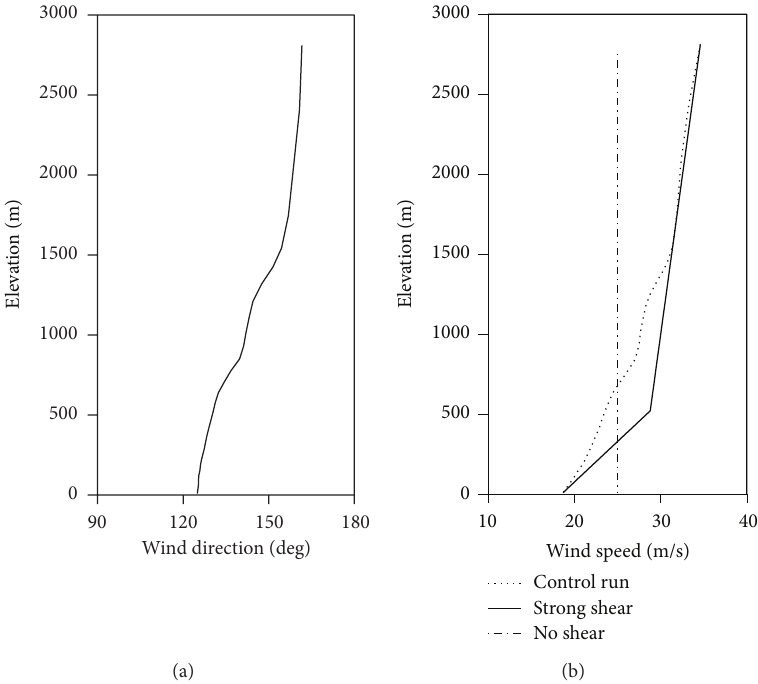
Figure 10: The vertical profile of wind direction (a) and the vertical profile of the three numerical simulations (b), namely, original (control, CTL), no shear (NS), and strong shear